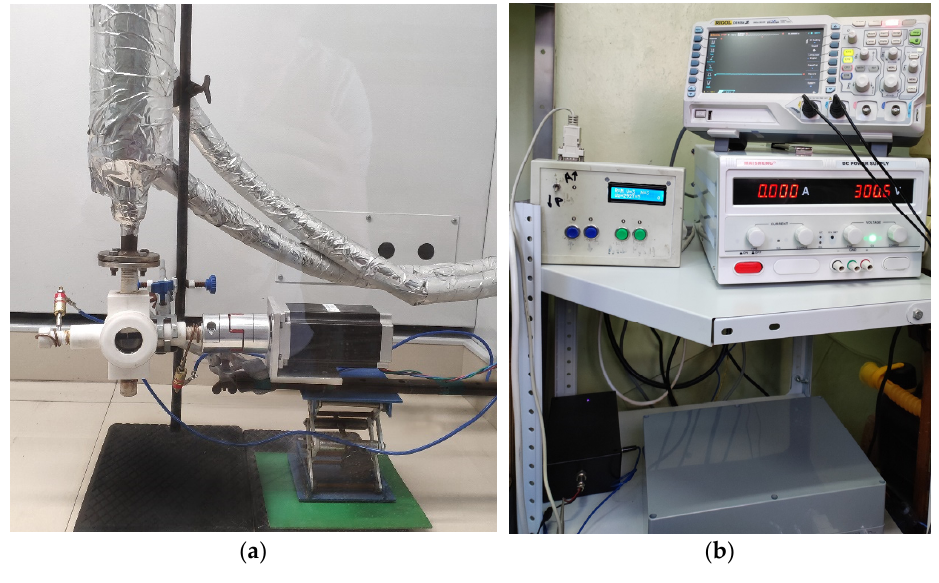
Figure 3. View of the reactor ( a ), control system, and DC power source ( b ).